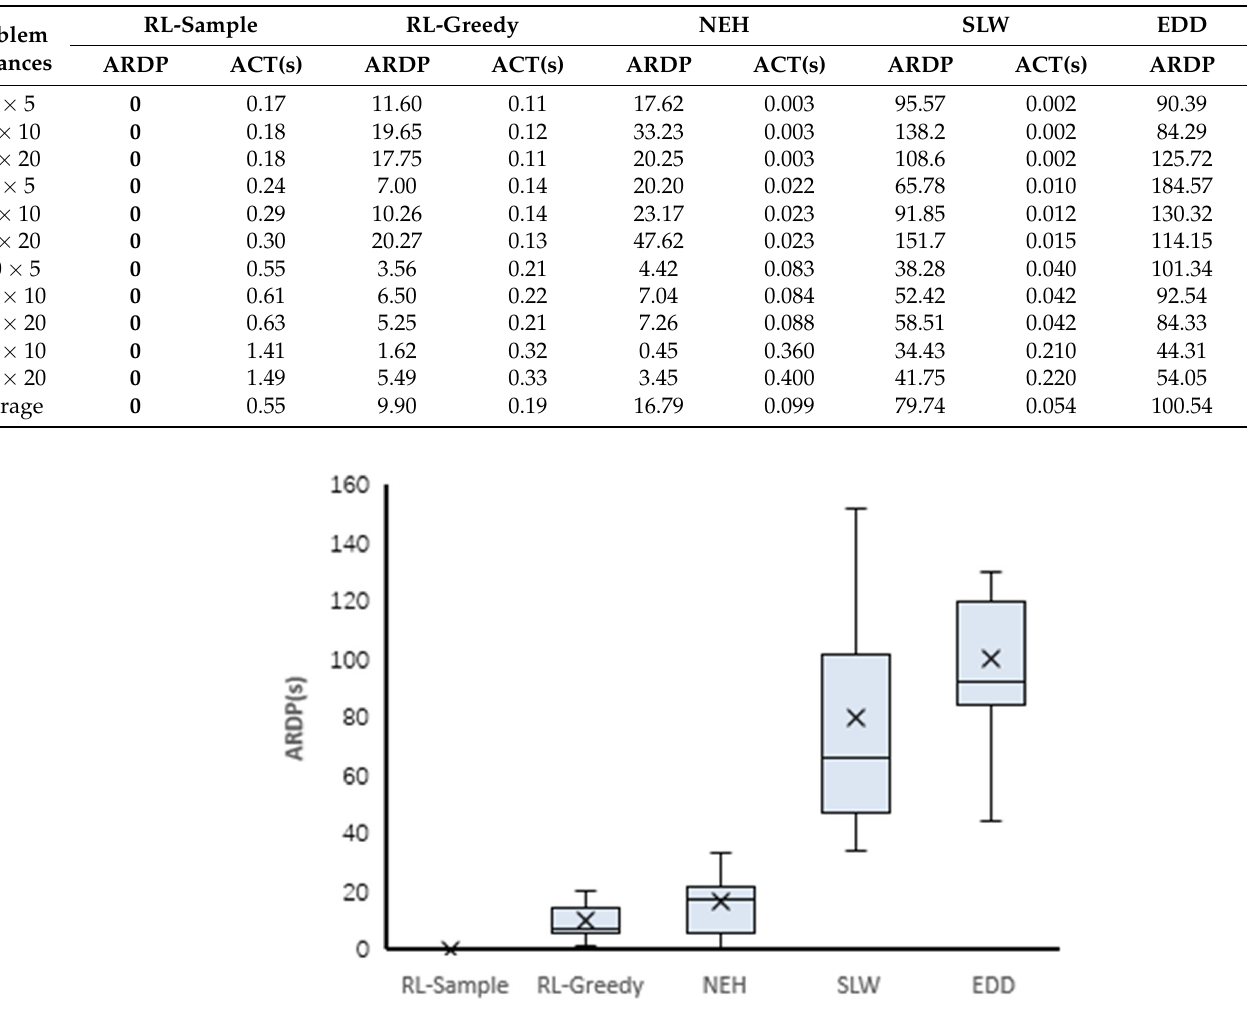
Figure 10. Box plot of RL and several heuristic algorithms.